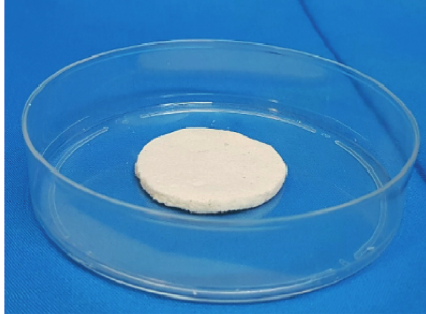
Figure 2: Amnion sponge in a Petri dish. Table 1: Comparison of TGF- β and bFGF levels in the preirradiated and postirradiated freeze-dried amnion membrane (FD-AM) with the amnion sponge.